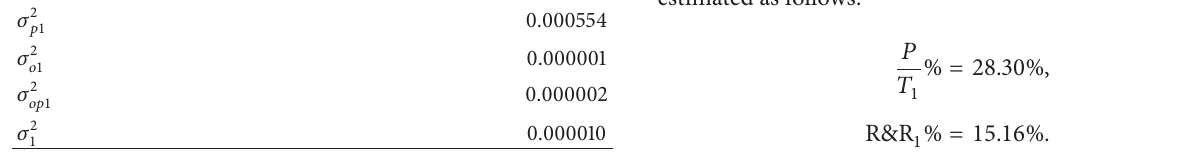
Table 2: Profile variance component of